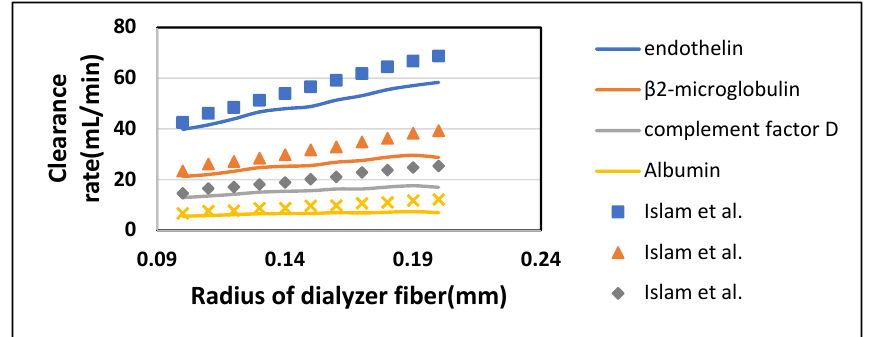
Figure 11. The clearance rate of low molecular weight solutes plotted against varying radius of the dialyzer at Q B = 300 mL/min and Q D = 500 mL/min.